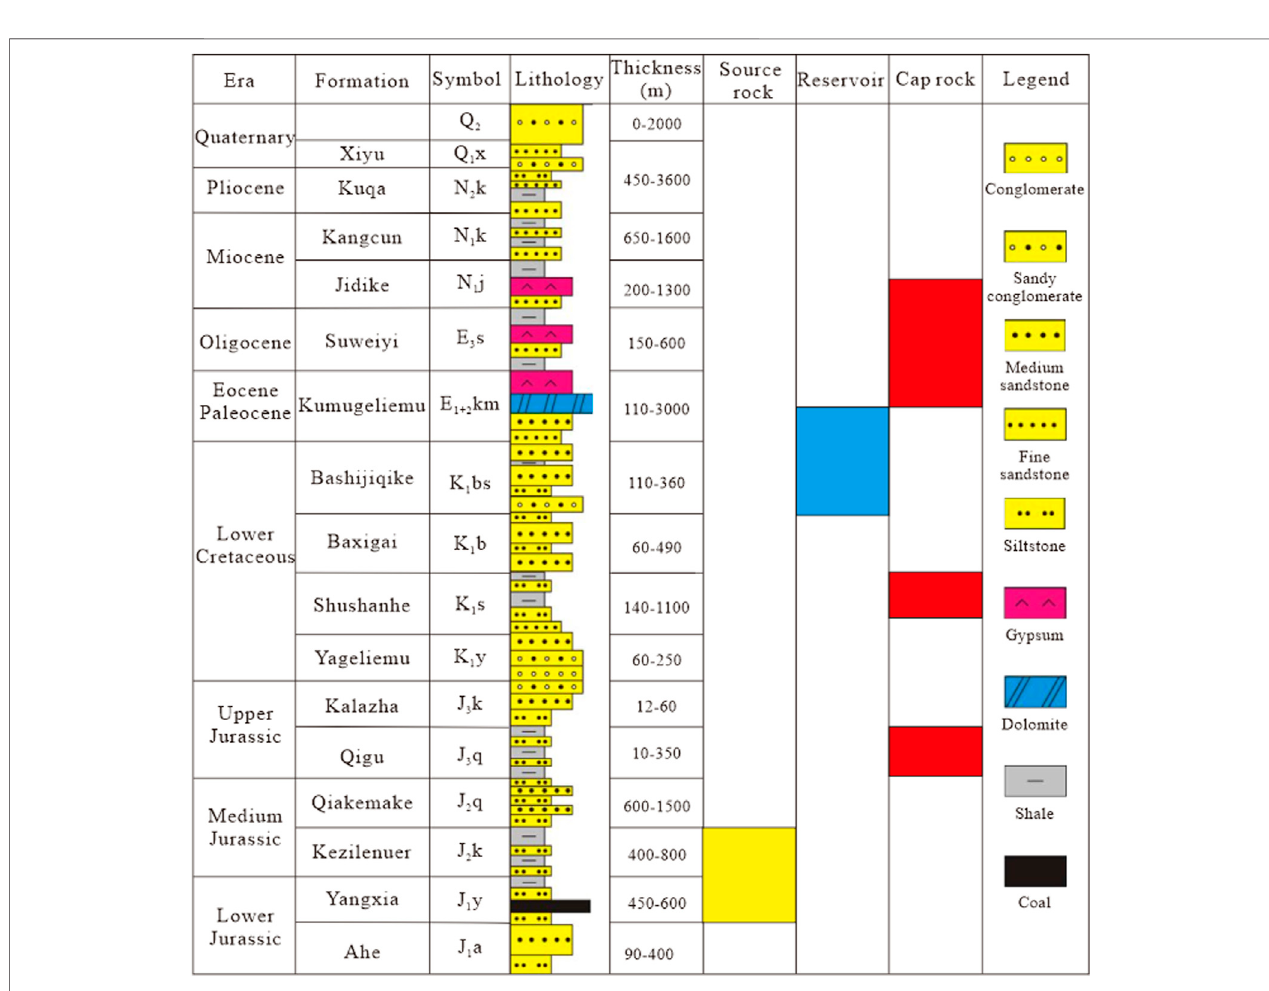
FIGURE 2 | Stratigraphic column of the Keshen gas fi eld (Lai et al., 2017).